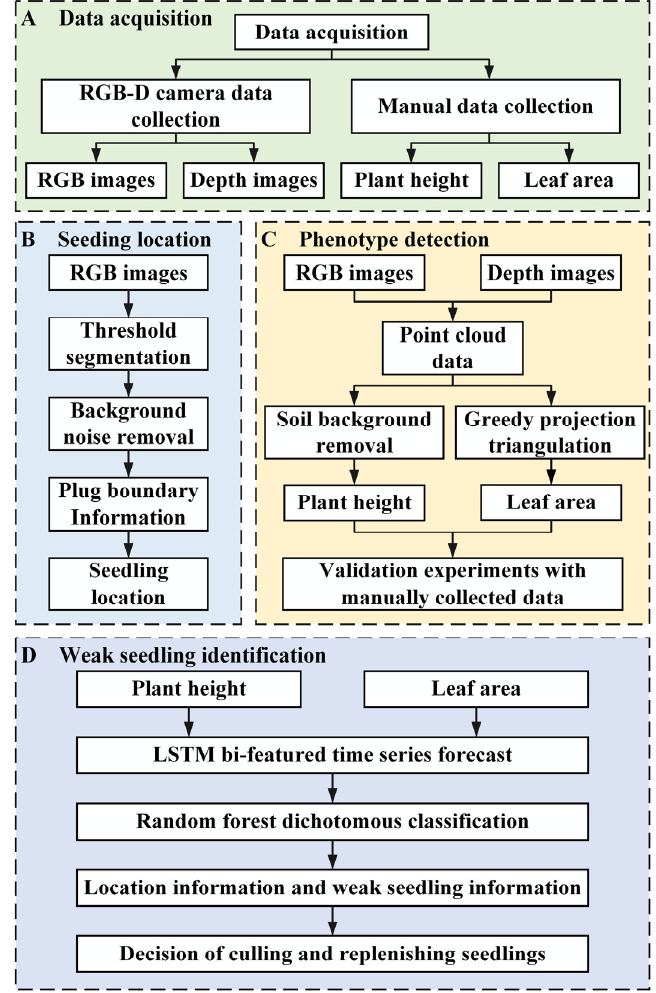
Figure 3. Technical method flow chart.